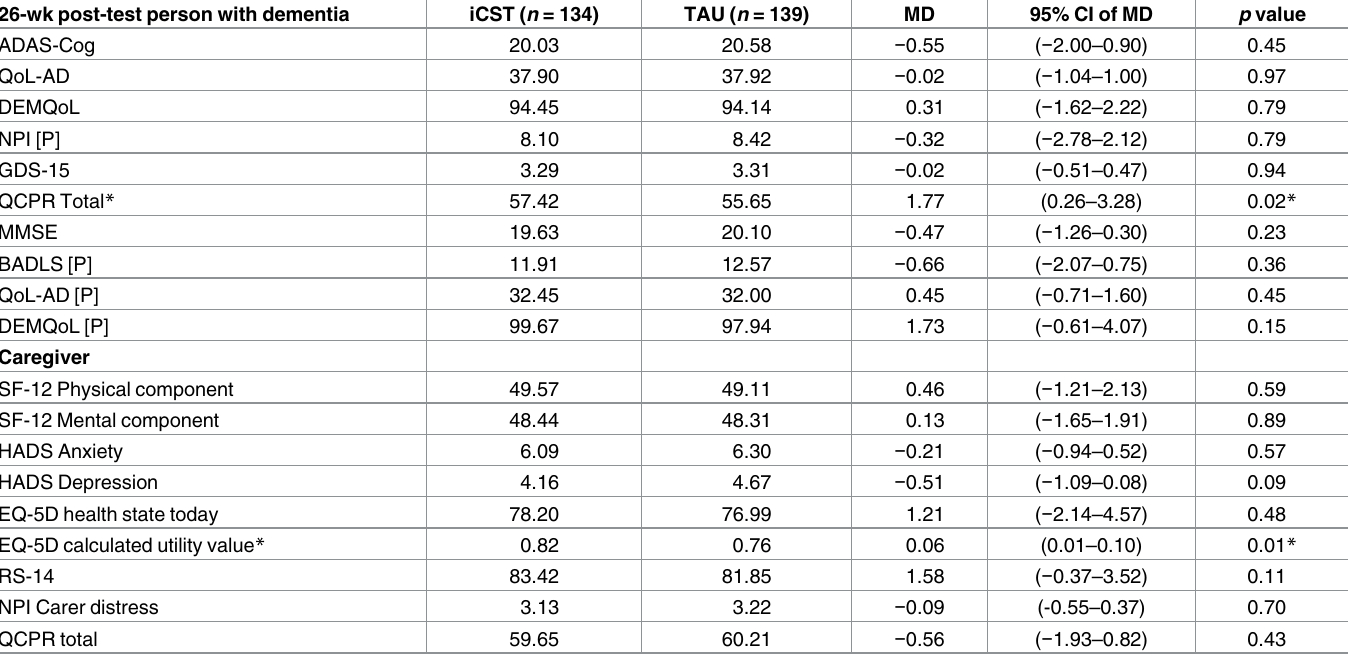
Table 2. Outcome measuresat 26-wk post-test by iCST versus TAU: Complete case analysis, adjusting for BL outcome measures,marital status, centre, age, and anticholinesteraseinhibitors. 26-wk post-test person with dementia